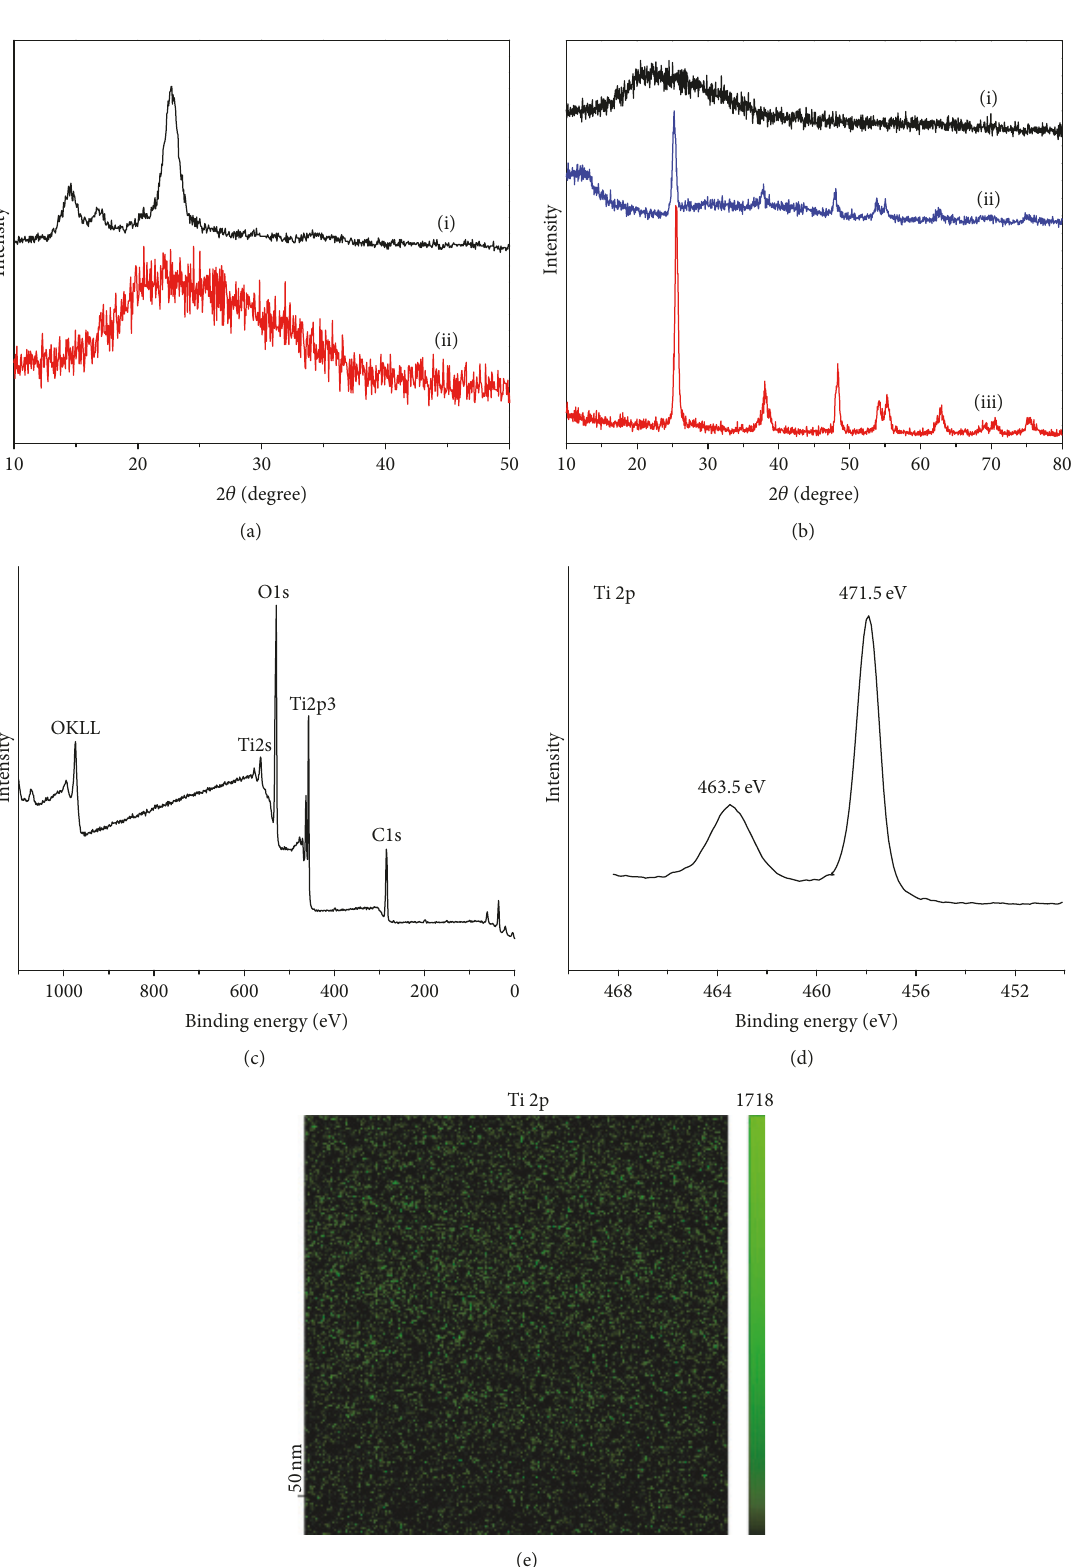
Figure 3: (a) XRD patterns of BC and regenerated BC fibers; (b) XRD patterns of spinning fiber, 0.1g TiO 2 /BC composite fiber, and TiO 2 ; (c) XPS spectrum of TiO 2 /BC hybrid fiber; (d) narrow spectrum of Ti element; (e) the mapping of Ti element in fiber